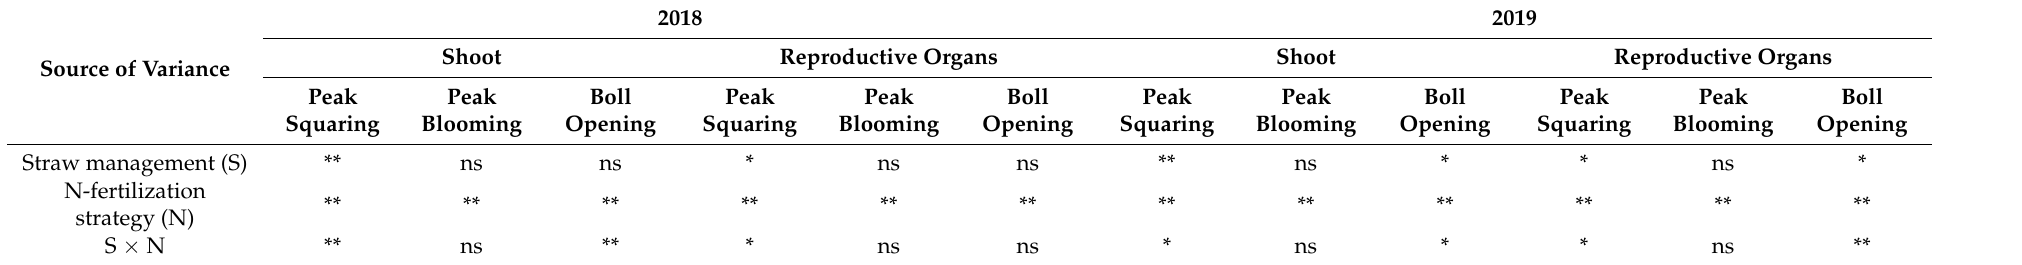
Table 2. Sources of variance in variance analysis for the biomass accumulation.